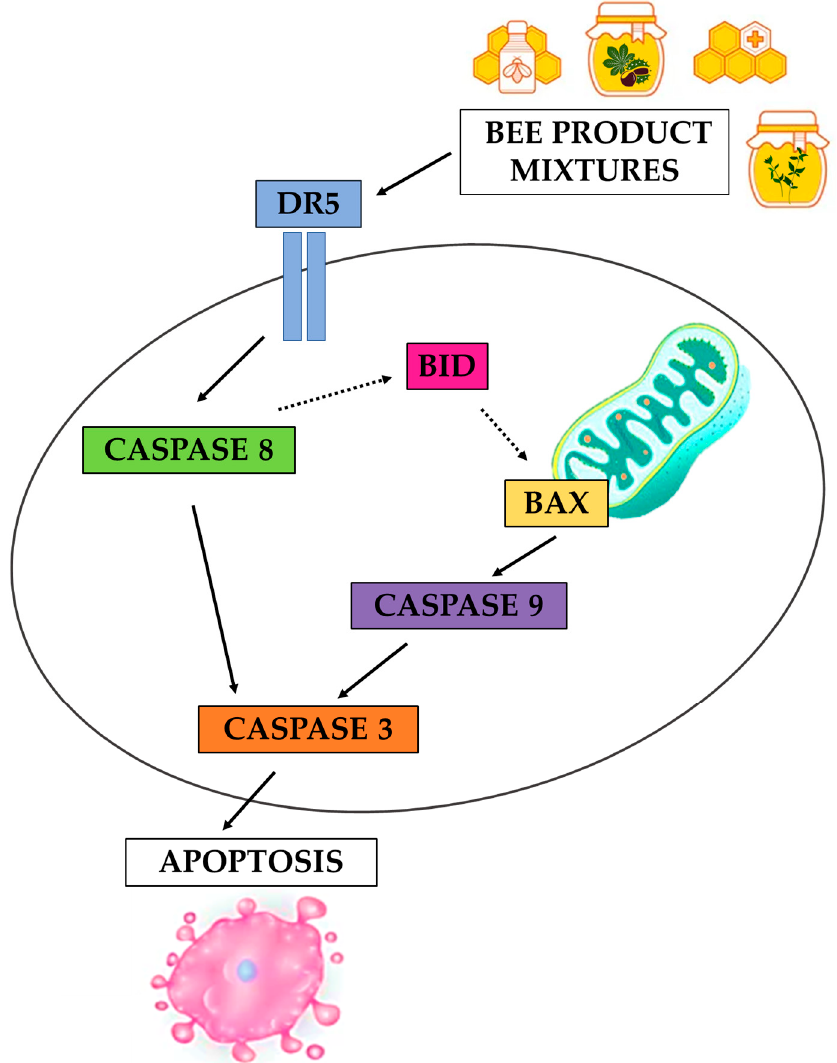
Figure 13. Proposed mechanism for the effect of bee product mixtures on the induction of apoptosis in liver cancer